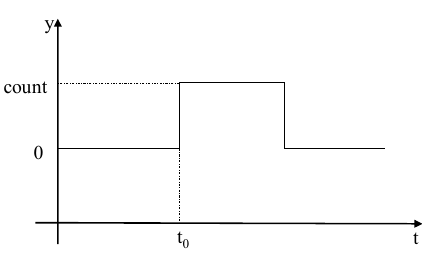
Figure 1. Schematic Diagram of Hard Fault Information.